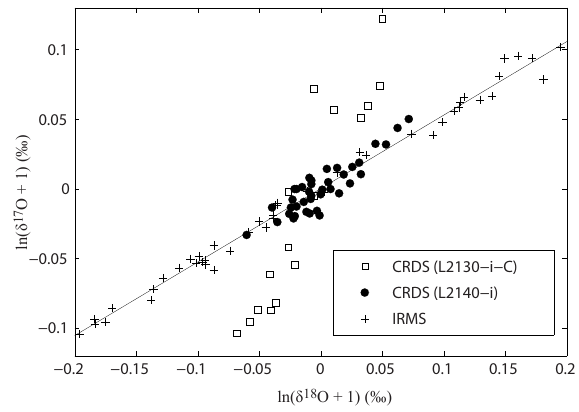
Figure 8. Relationship between ln (δ 17 O + 1 ) and ln (δ 18 O + 1 ) resid- uals for 40 vials of identical water, each injected 10 times in the L2140- i CRDS. Small gray dots show every 100th high-frequency 0.8 s measurement, large circles the individual injection means,“+”- signs the vial-mean values. The slopes of the 0.8 s and individual in- jection data are 0 . 82 ± 0 . 02 and 0 . 59 ± 0 . 02, respectively ( ± = 2 σ ). The slope of the vial-mean data is 0 . 54 ± 0 . 03, shown by the line.